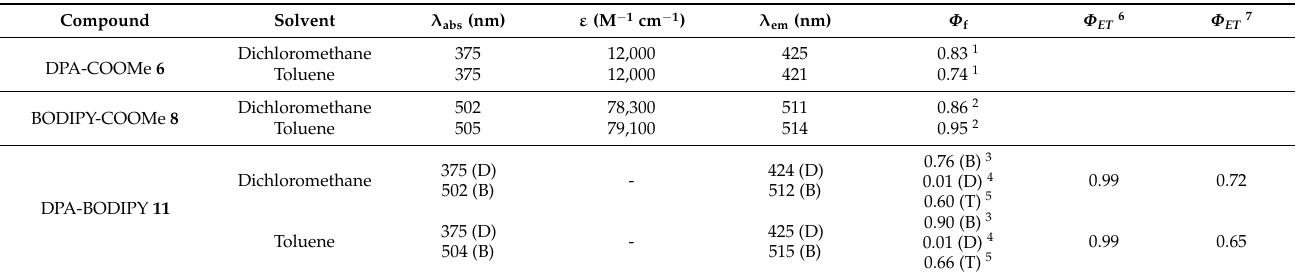
Table 1. Photophysical properties of the synthesized compounds.